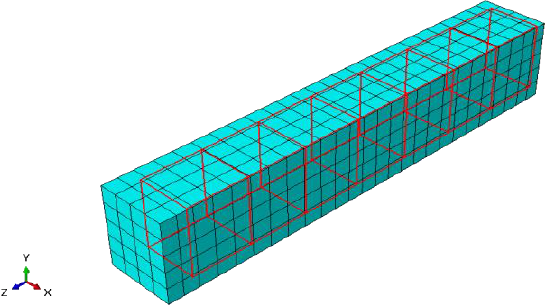
Figure 9. Assembly of concrete and steel reinforcements in a beam.